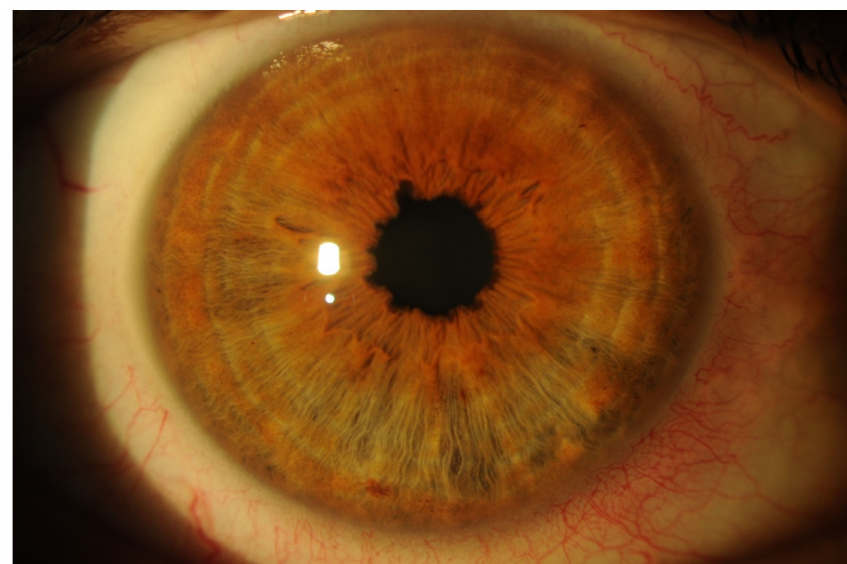
Figure 9. Slit-lamp examination of pupillary indentations considered as a pathognomonic sign of ocular amyloidosis caused by amyloid deposition at the inner pupillary margin (magnification 10 × and diffuse